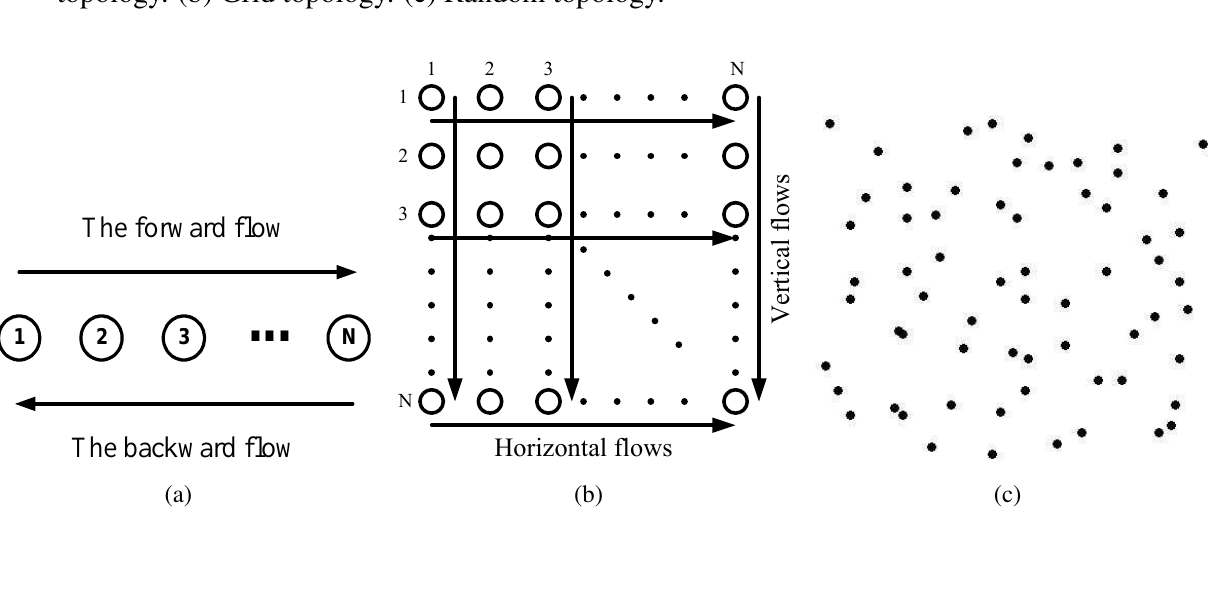
Figure 6. The three types of network topologies used in the ns-2 simulations. (a) Chain topology. (b) Grid topology. (c) Random topology.